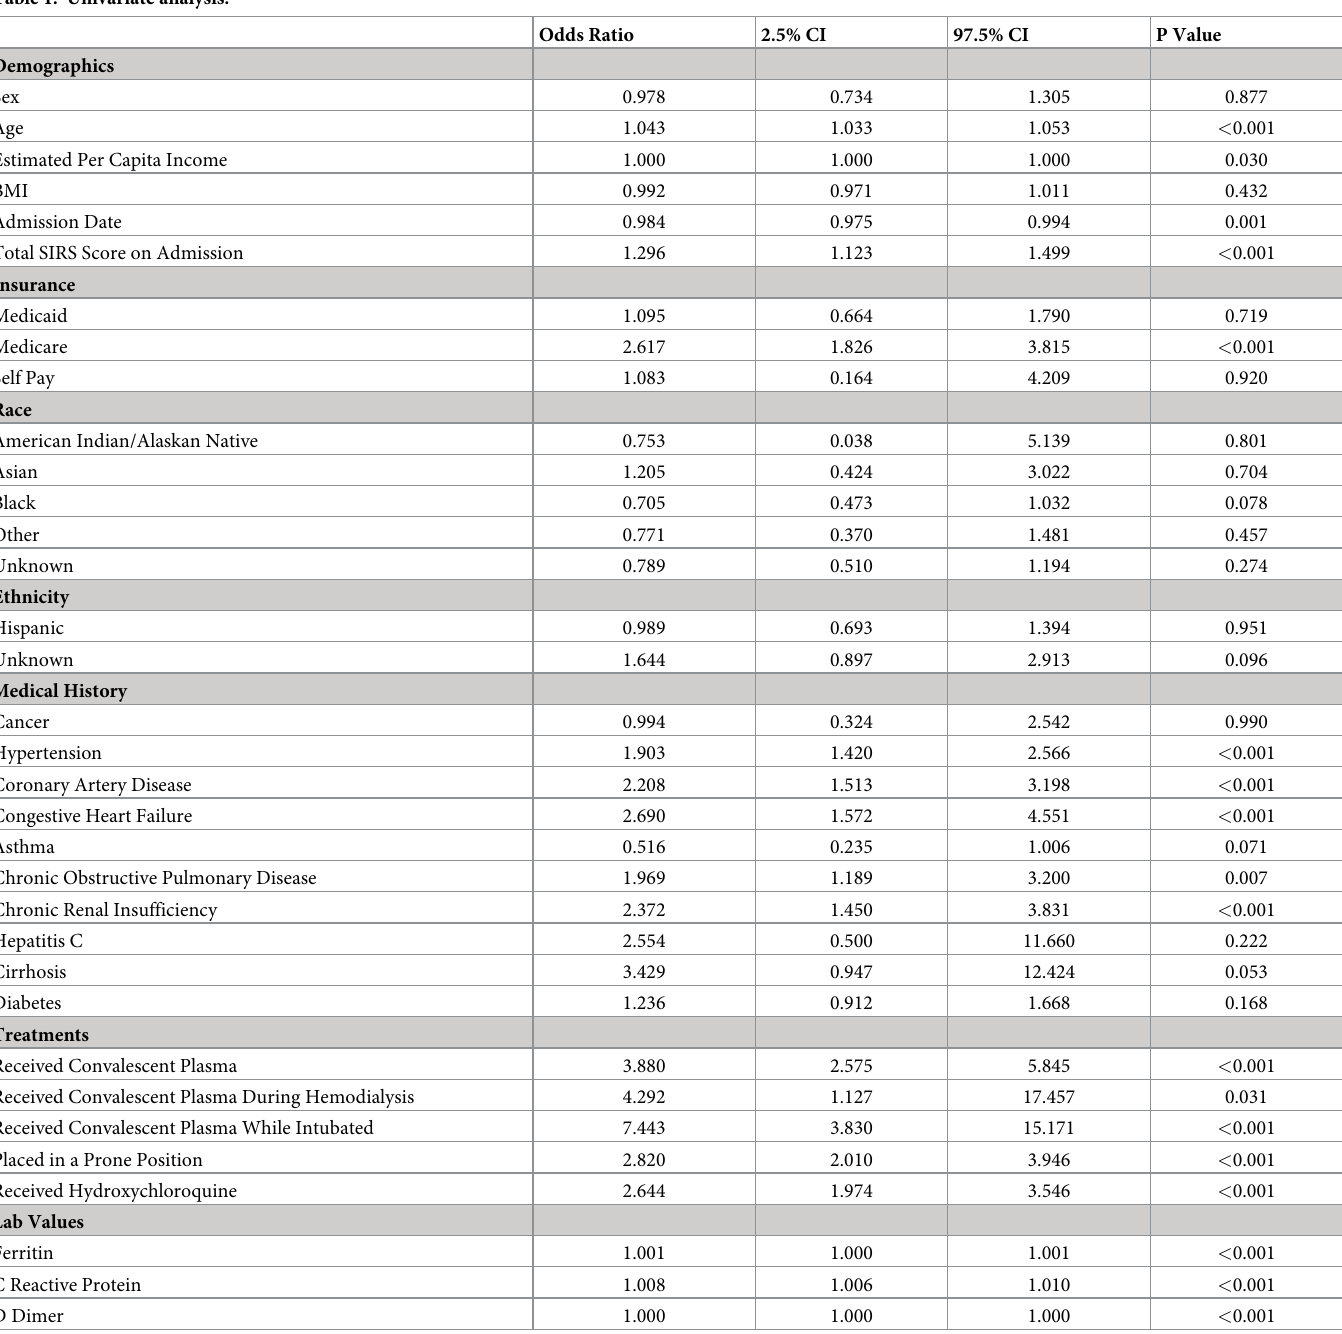
Table 1. Univariate